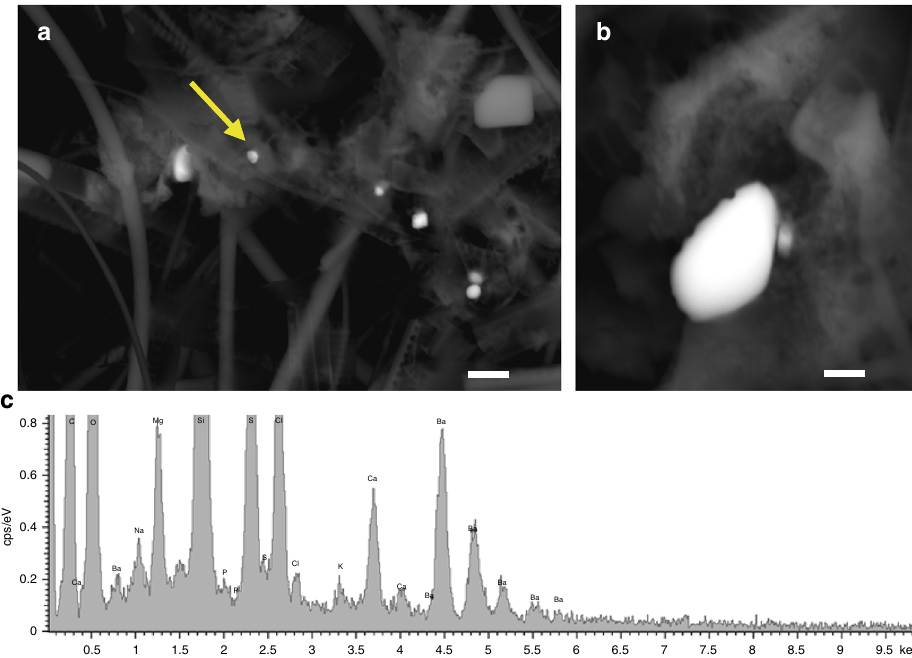
Fig. 5 SEM images and composition of natural barite from the ocean. a , b SEM micrographs showing examples of marine barite particles from the ocean water column (North Atlantic) in sinking particulate matter collected using a multiple-unit large-volume in situ fi ltration system. Scale bar represents 3 μ m in a and 1 μ m in b . c Representative spectrum showing the composition of barite particles. The spectrum corresponds to the particle indicated with the arrow in photograph a , and shows the P enrichment in natural marine